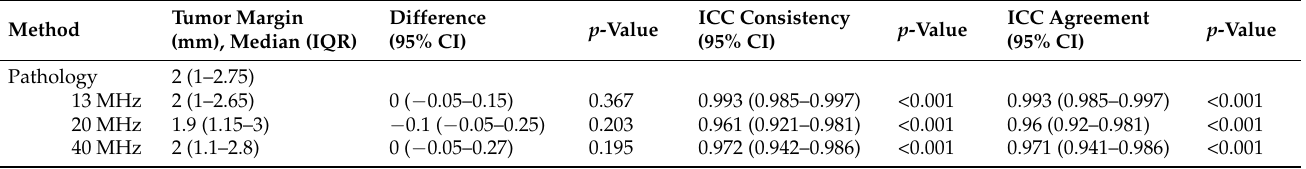
Figure 8. Surgical margins measurement by US and histopathology. Table 5. Correlation between the ultrasound measurement of the surgical margins and pathological reports.